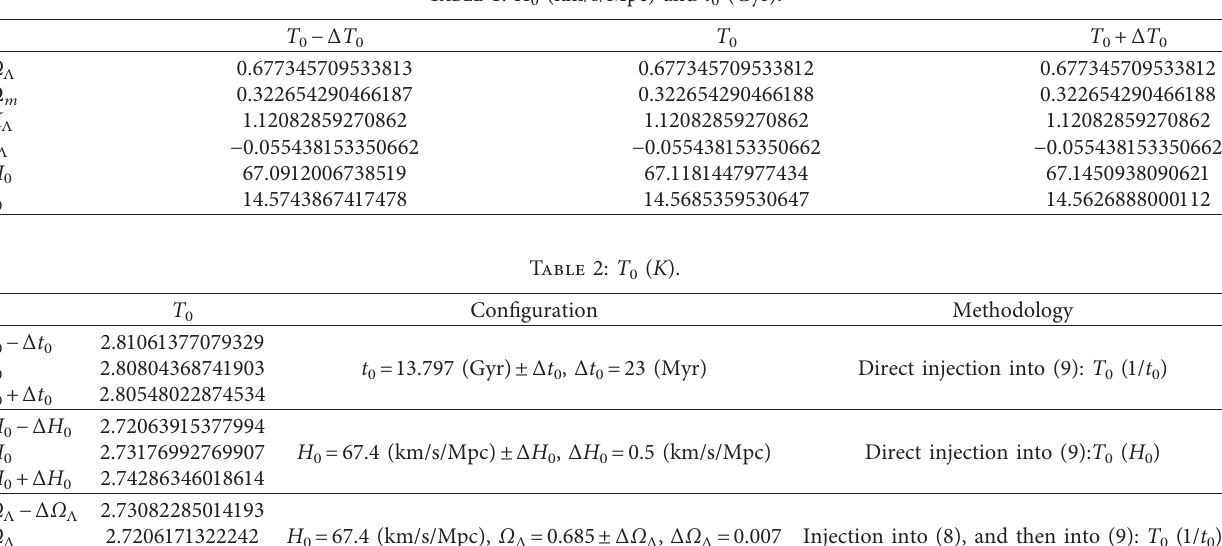
Table 1: H 0 (km/s/Mpc) and t 0 (Gyr).